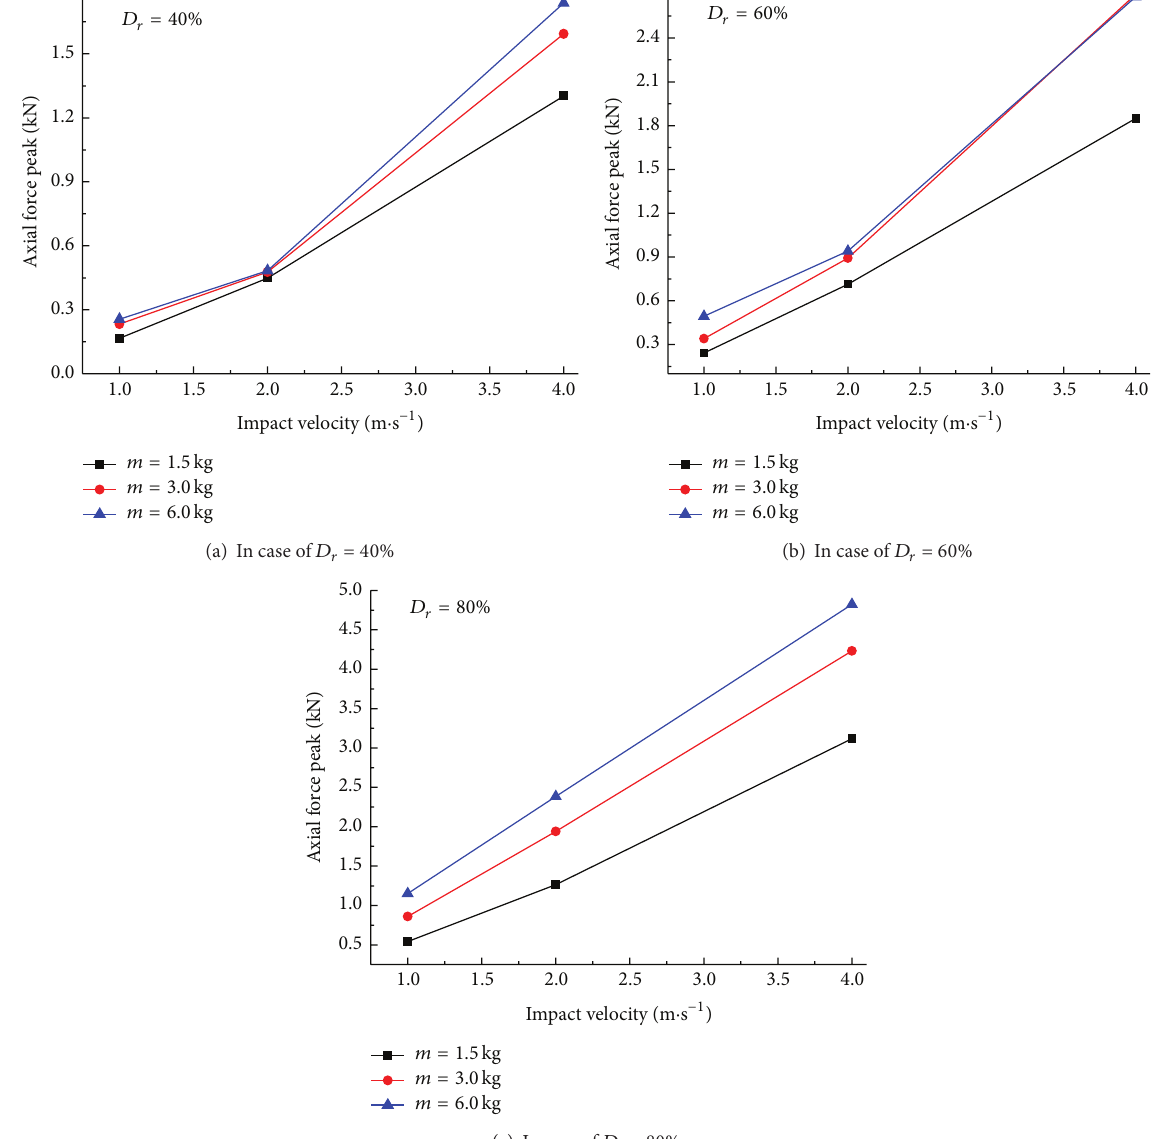
Figure 20: Effect of impact velocity on peak axial force.